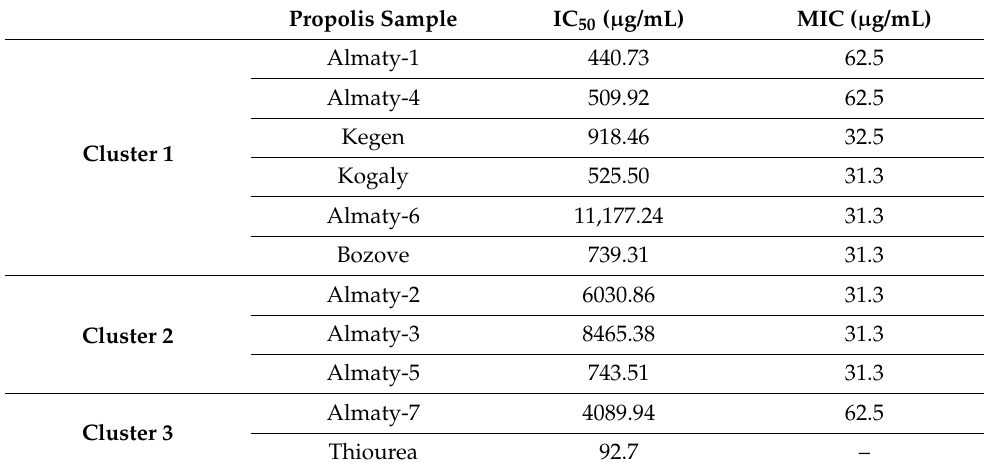
Table 5. Antibacterial activity (MIC) against reference H. pylori strain and inhibition of H. pylori urease activity (IC 50 ) by tested 70EEP.